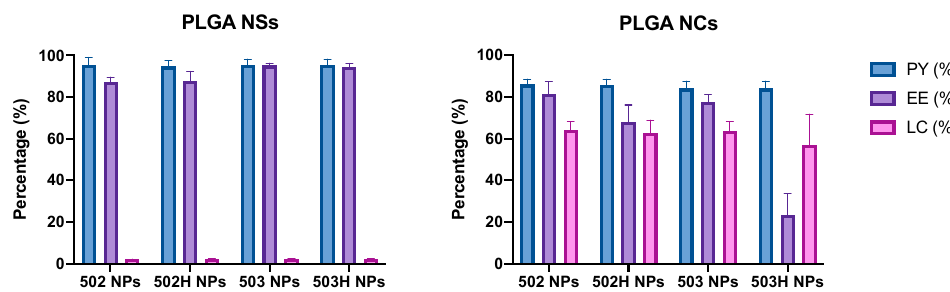
Figure 5. PY, EE, and LC values for PLGA-nanoparticles. No statistically significant differences were found in terms of PY and EE ( p > 0.05). Nevertheless, considerable differences were observed for LC values, where NCs-based formulations permitted the obtention of higher Lf-embedded content into the polymer matrix, compared to the NSs-based formulations ( p < 0.0001).